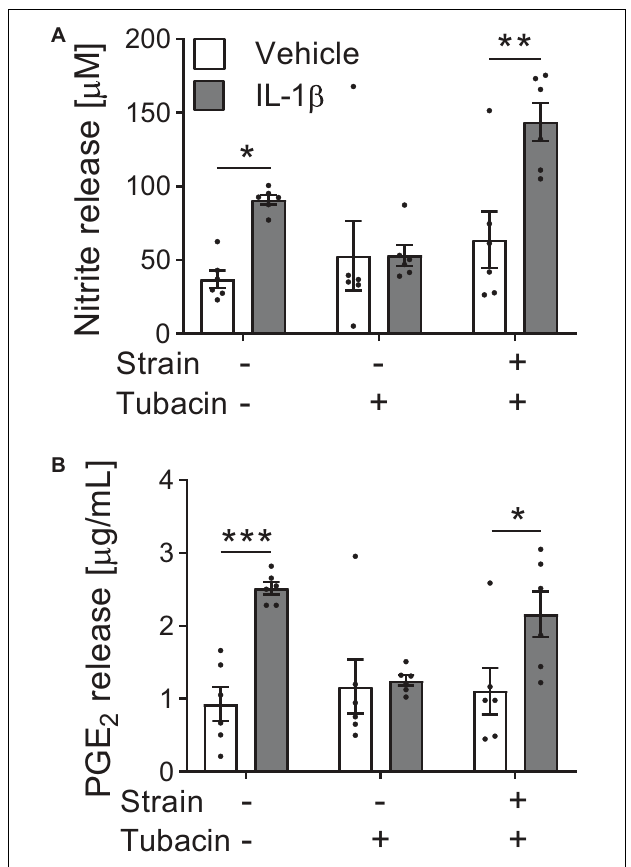
FIGURE 2 | Tensile strain blocks the anti-inflammatory effects of tubacin. Bovine articular chondrocytes cultured in the presence of vehicle or interleukin-1 β (IL-1 β ) were treated with HDAC6 inhibitor tubacin and/or cyclic tensile strain of 10% at 0.33 Hz for 24 h using a Flexcell R (cid:13) FX5000 cell tension system. (A) Nitrite (nitric oxide) and (B) prostaglandin E 2 (PGE 2 ) release. n = 6; Two-way ANOVA with Sidak pairwise comparisons: * P ≤ 0.033, ** P = 0.0011, *** P = 0.0004. Mean ± s.e.m. with individual values overlaid. Data adapted from Fu et al. (2019) where further details of methods can be